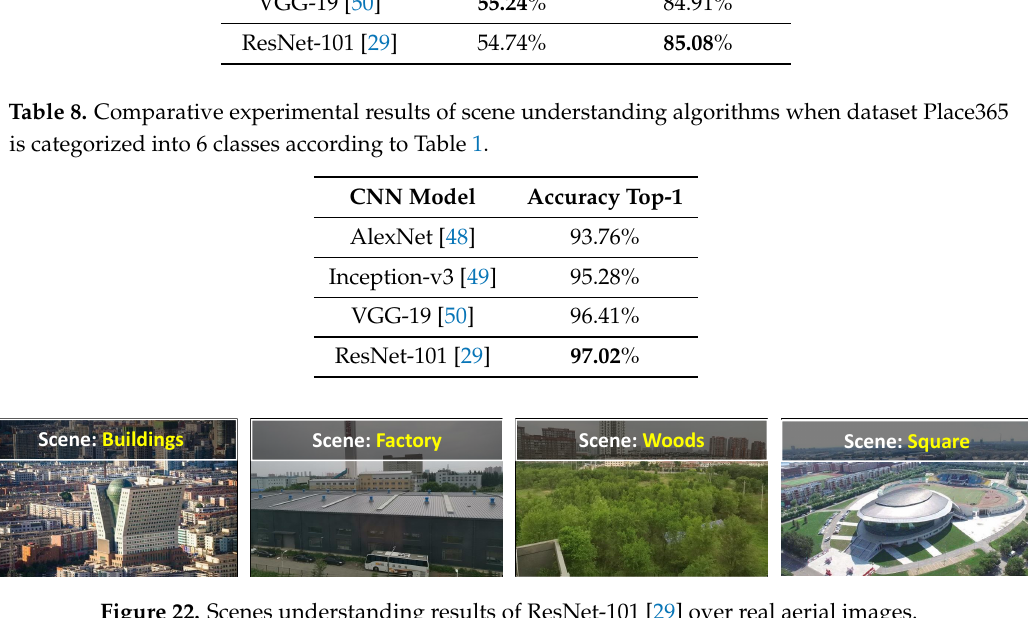
Figure 22. Scenes understanding results of ResNet-101 [29] over real aerial images.